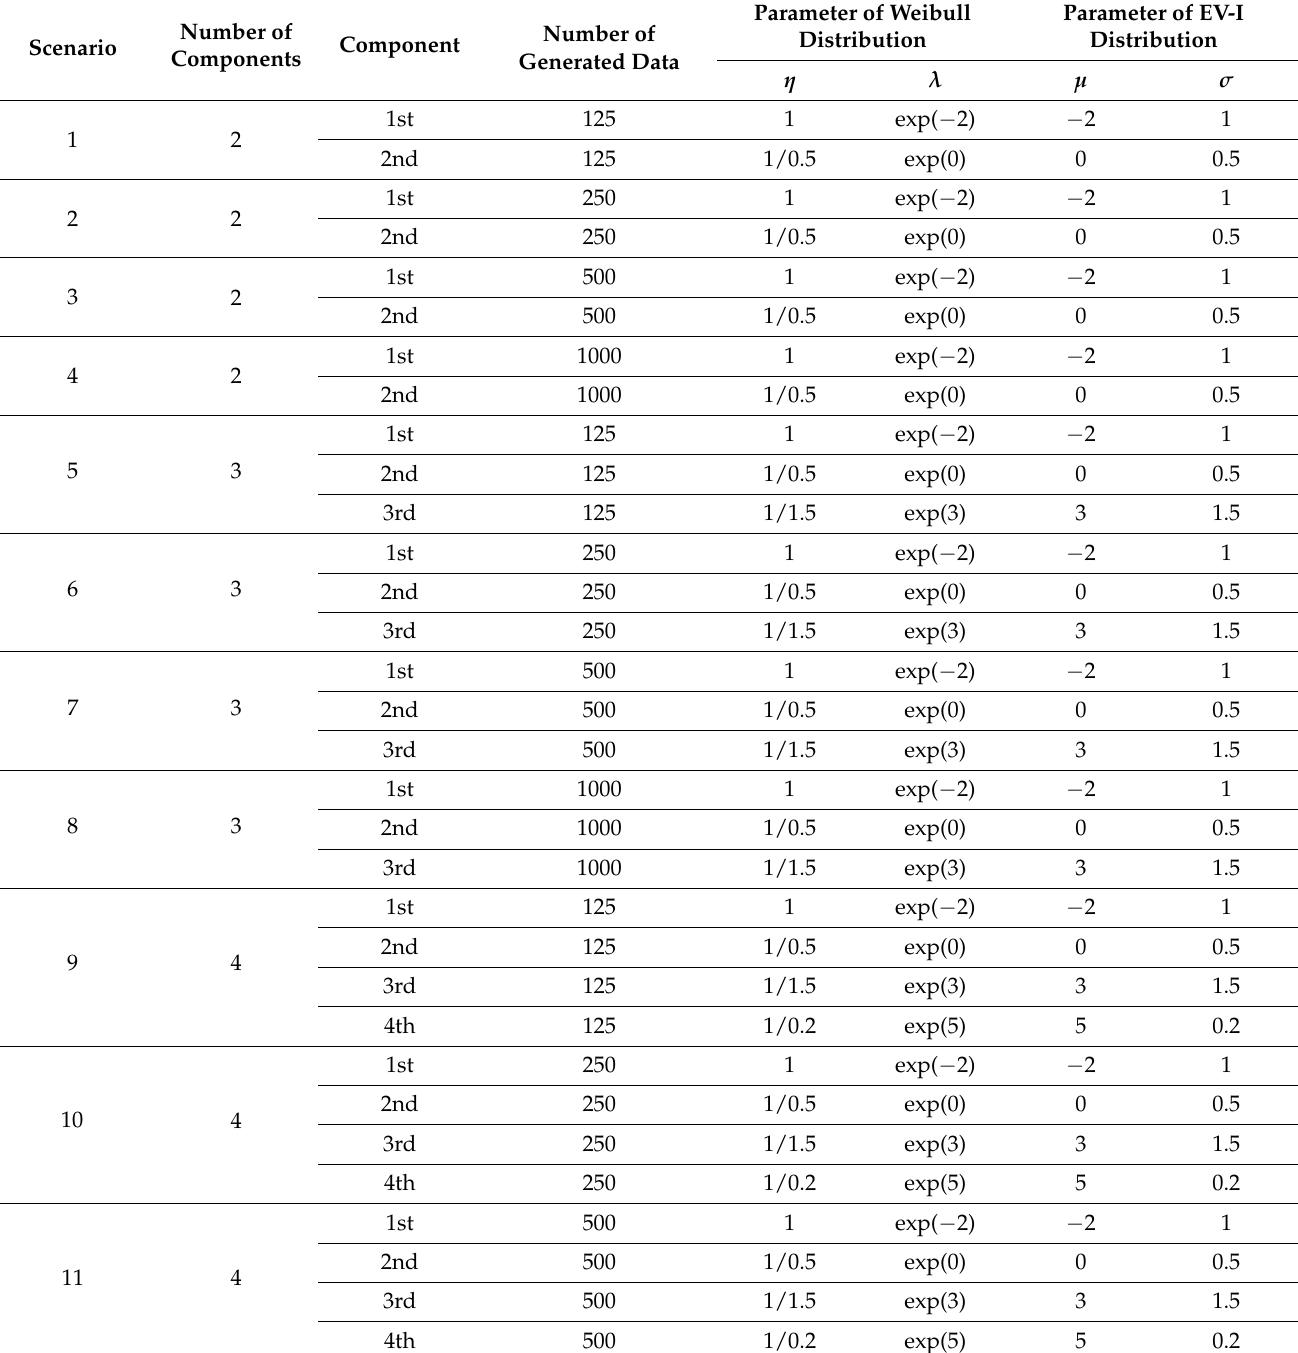
Table 1. Sixteen scenarios of the Weibull mixture distribution and their transformation into the EV-I mixture distribution.